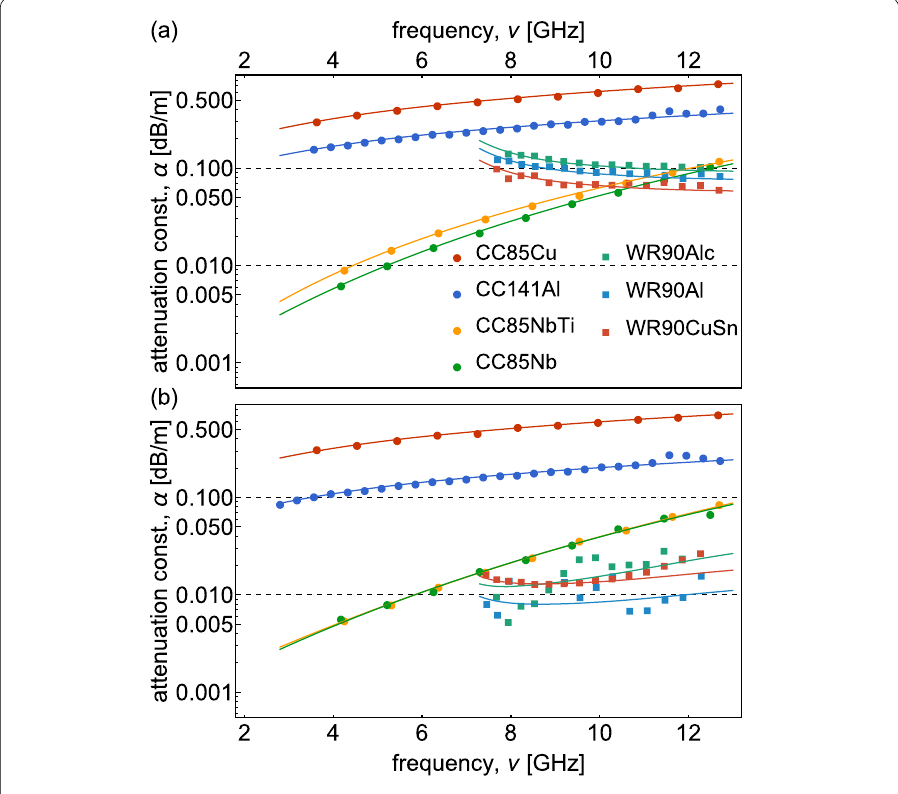
Figure 6 Comparison of measured attenuation constants. Attenuation constant α (dots) extracted from measurements at frequency ν for CC085Cu, CC141Al, CC085NbTi, CC085Nb, WR90Alc, WR90Al and WR90CuSn. (a) shows the measurement results at approximately 4 K and (b) the measurement results at BT. The attenuation constant α is plotted in dB/m in a log-plot to cover the full range of measured losses. The solid lines are calculated from the fits to Q i measurements using the same model as for the